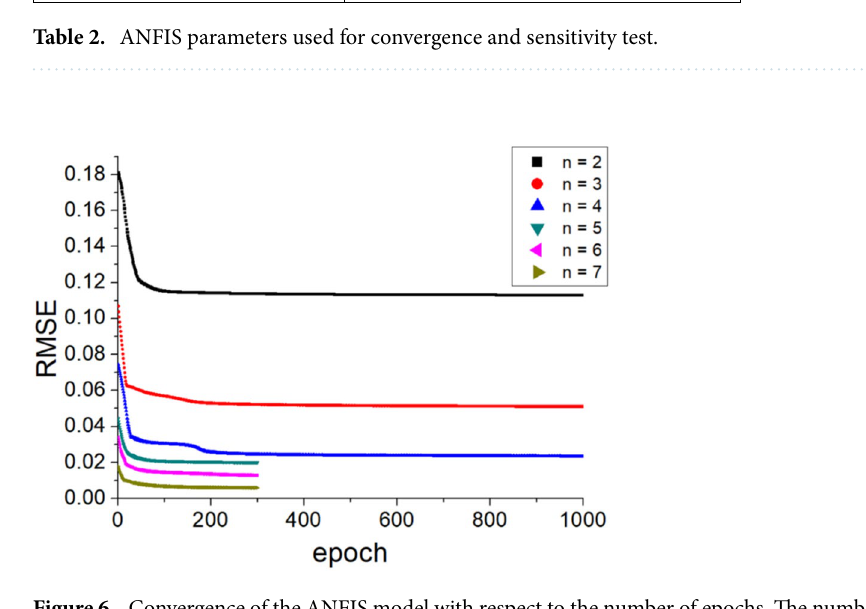
Figure 6. Convergence of the ANFIS model with respect to the number of epochs. The number of epochs reached 300, the degree of convergence of the model was